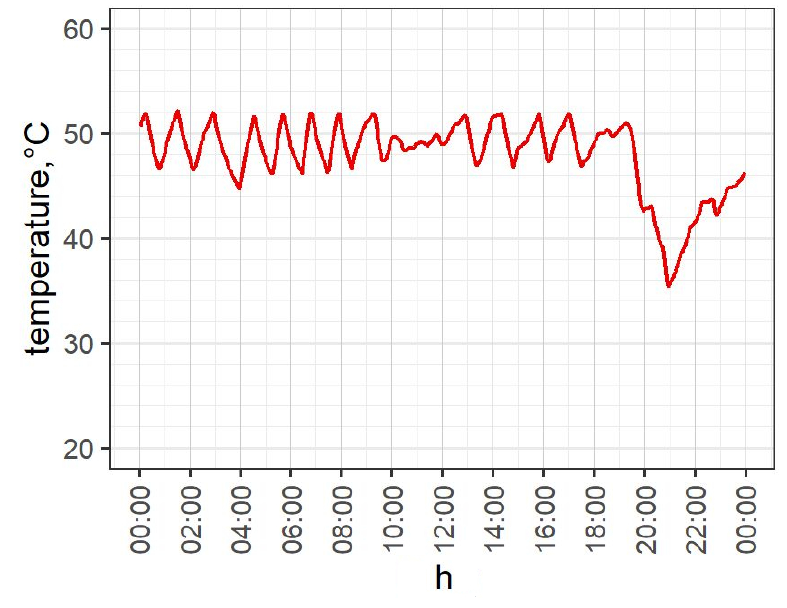
Figure 4. Examples of daily changes in hot water temperature in boiler room